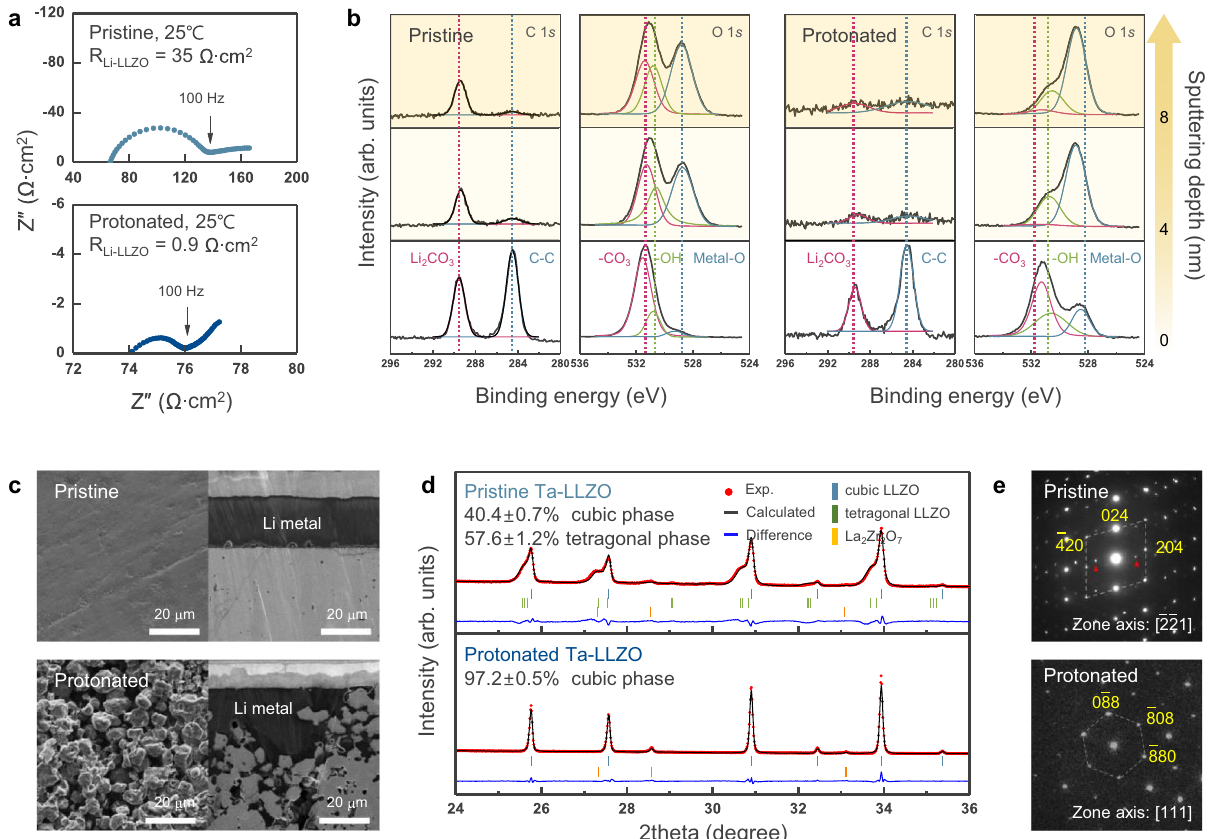
Fig. 2 Surface stabilisation effects on Ta-doped-LLZO through acid treatment. a Decrease in the interfacial resistance in Li/Ta – LLZO/Li symmetric cell before and after surface tailoring. b XPS spectra of C 1 s and O 1 s region along the sputtering depth, showing the elimination of Li 2 CO 3 below the surface. c SEM images of the polished and tailored pellet surfaces and cross-sections in contact with lithium metal. The protonated pellet shows pronounced rough and porous surface morphology. d XRD and e SAD patterns of Ta – LLZO before and after surface stabilisation. XRD patterns in d indicate that pristine Ta – LLZO includes 40.4 ± 0.7 wt% of cubic phase ( Ia (cid:1) 3 d , a = 12.93 Å) and 57.6 ± 1.2 wt% of the tetragonal phase ( I 4 1 = acd , a = 13.03 Å, c = 12.94 Å, c / a = 0.9928), whereas protonated Ta – LLZO consists of 97.2 ± 0.5 wt% of cubic phase ( Ia (cid:1) 3 d ) with a lattice parameter of 12.93 Å. The peak of the pristine pellet is clearly asymmetric due to the presence of the tetragonal phase. (Details of the Rietveld re fi nement are provided in Supplementary Figs. 18 and 21, and details of the re fi nement approaches are described in the Methods section.) In e , SAD pattern from the surface region of the pristine Ta – LLZO along the [ (cid:1) 2 (cid:1) 21] zone-axis shows the spots corresponding to the tetragonal phase. The extra spots indicated by the red arrows represent the existence of an additional phase with a similar crystal structure that might be attributed to the strain fi eld, causing double diffraction. In contrast, protonated Ta – LLZO clearly shows a diffraction pattern corresponding to a single cubic